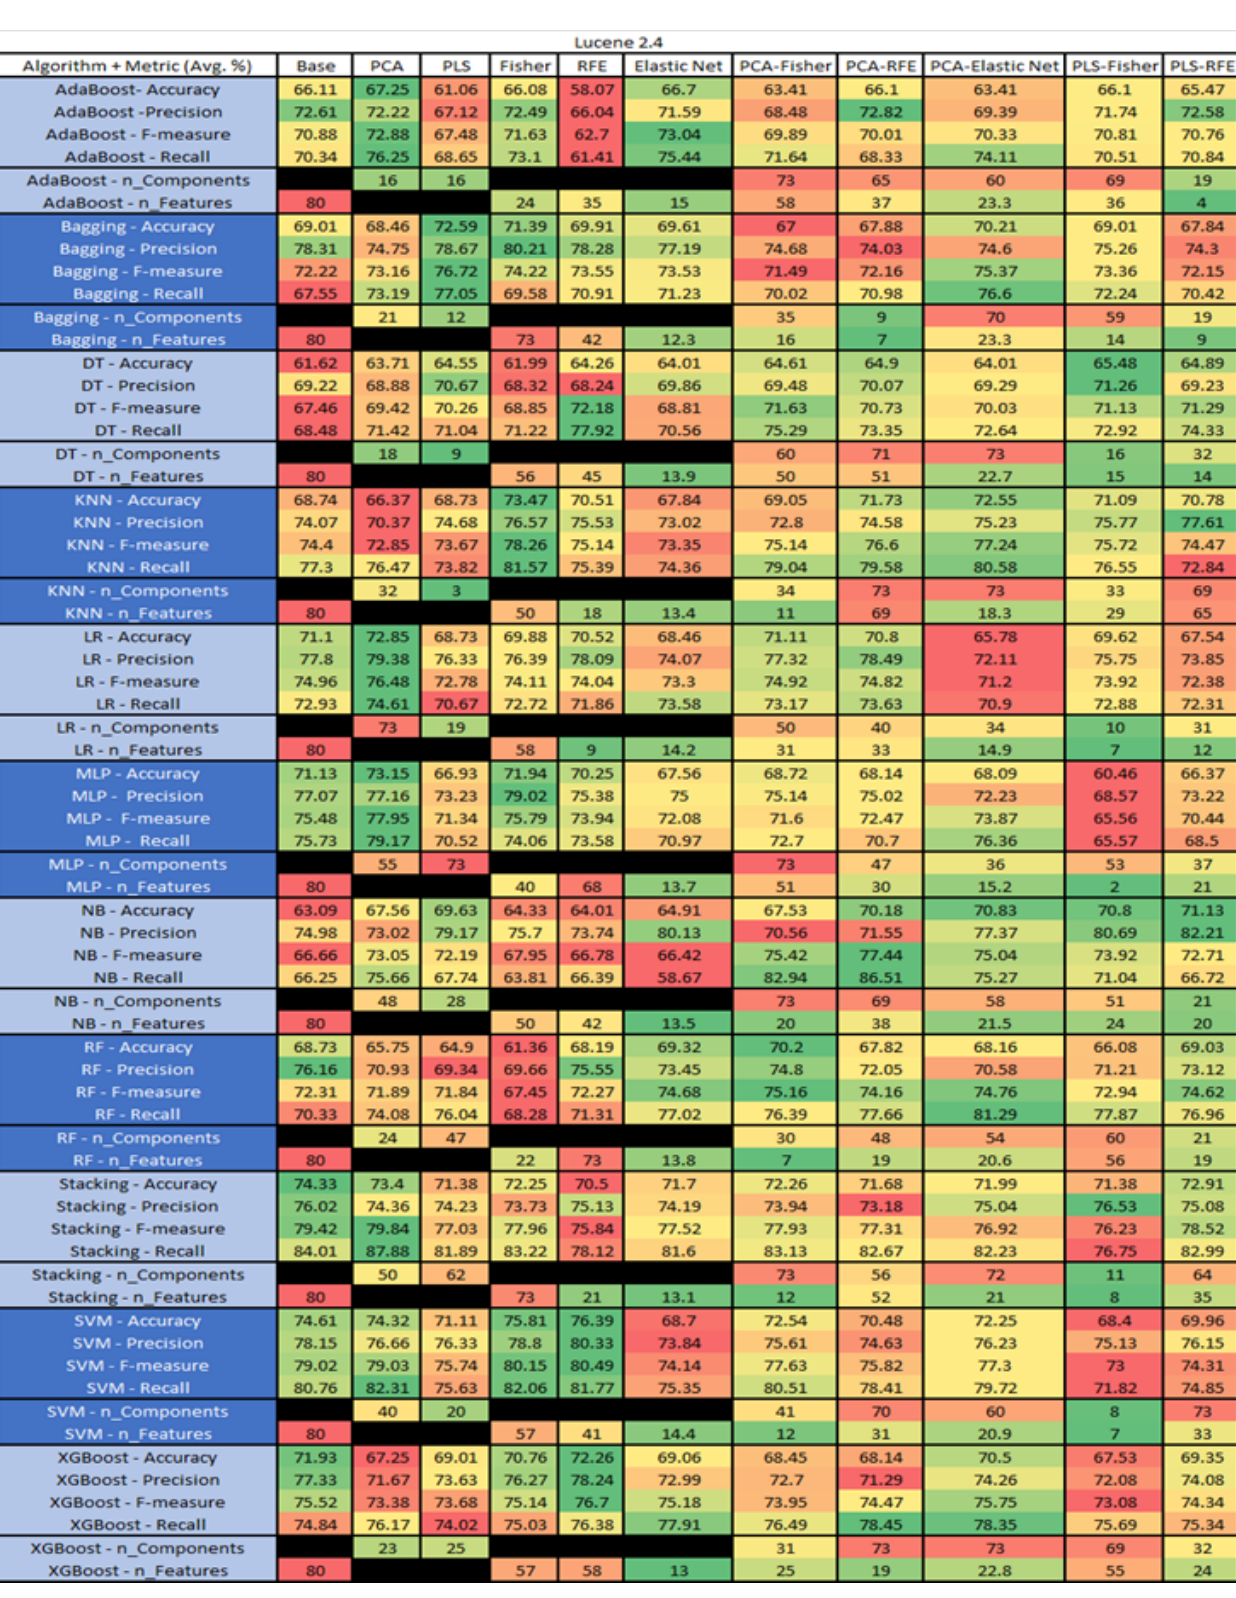
Figure 32. Lucene 2.4 PROMISE Results Data